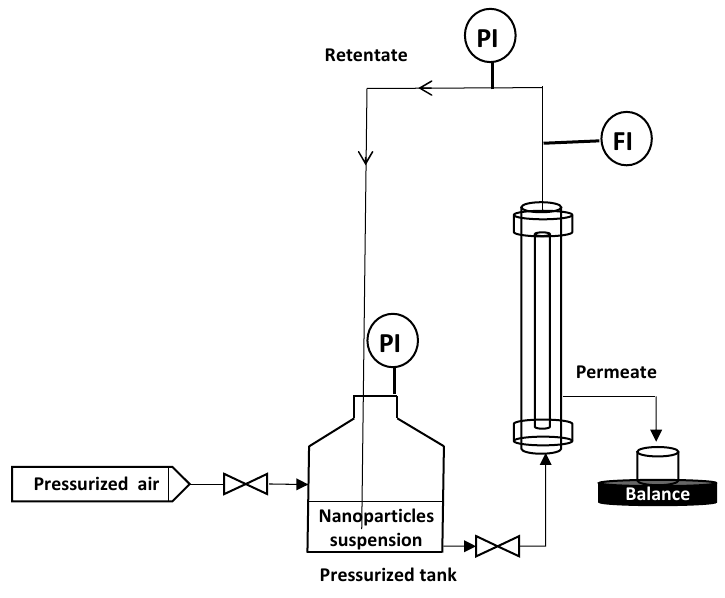
Figure 3. Schematic diagram of the vertical cross flow filtration set-up.